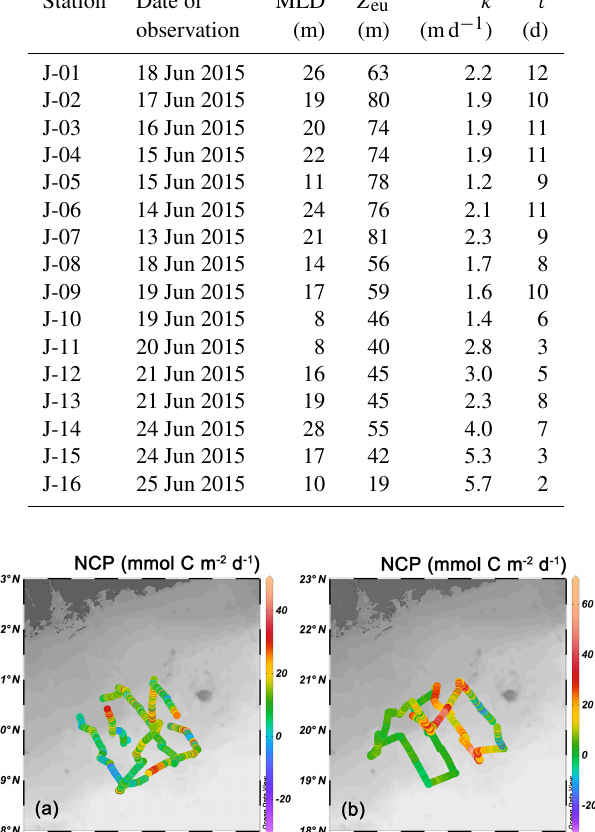
influenced by exponential light attenuation along the depth